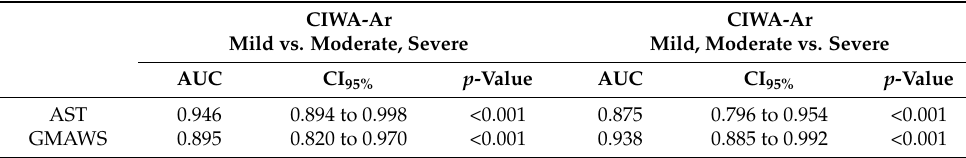
Figure 1. Diagnostic ability of AST scale. The figure shows Receiver Operating Characteristics of AST scale during discriminating mild AWS vs. moderate and severe AWS ( left panel ), as well as mild and moderate AWS vs. severe AWS ( right panel ). AST is shown in blue and GMAWS in green. Abbreviations: AWS, Alcohol Withdrawal Syndrome. Table 3. The discriminant ability of AST and Glasgow Scores for severity of